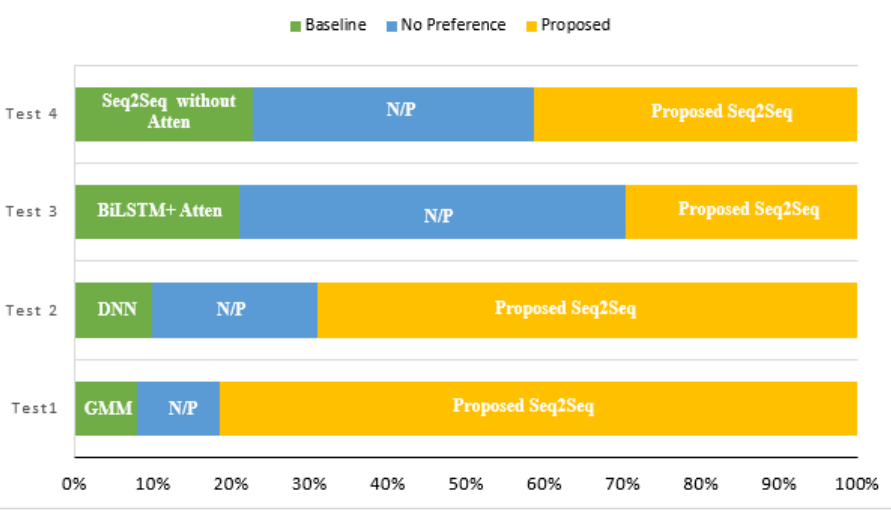
Figure 7. ABX preference test results for baseline and proposed methods. NP means no